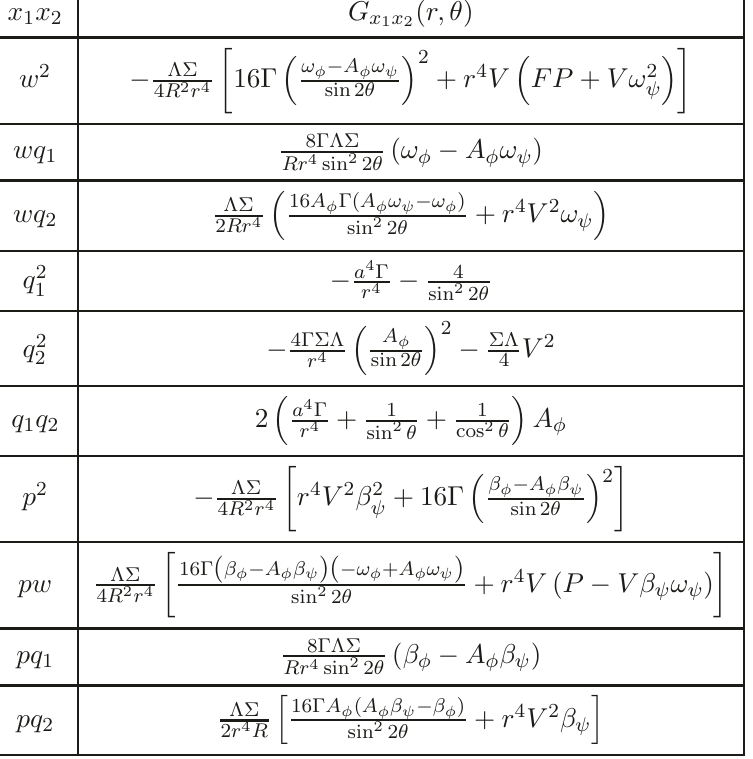
Table 2: (1 , 0 , n ) and (1 , 1 , n ) wave